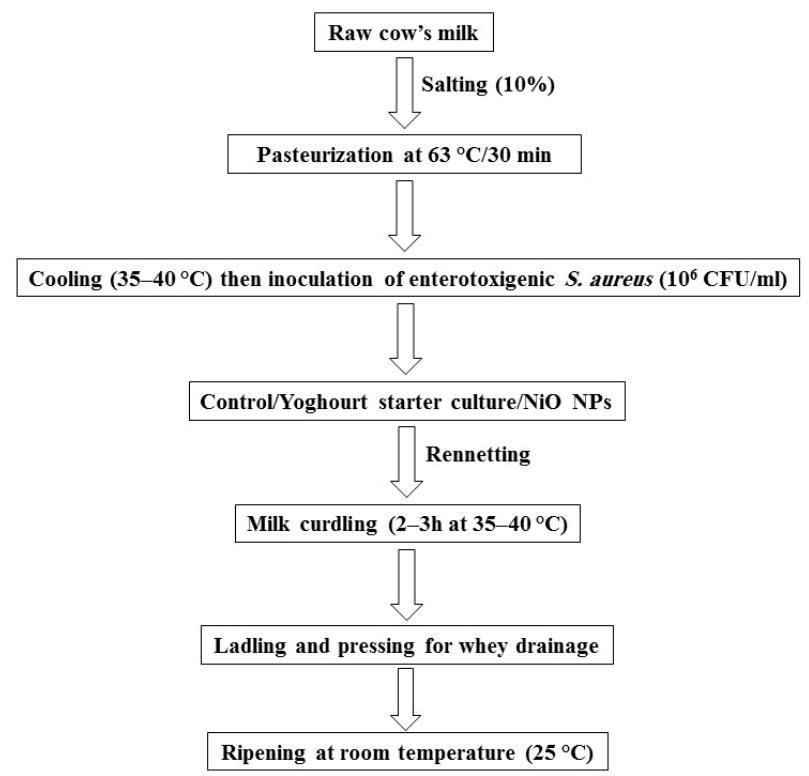
Figure 1. Flow diagram of Domiati cheese making. Control cheese; normal cheese without any treatment. Yoghourt starter culture cheese; cheese processed by addition of yoghourt. NiO NPs cheese; Domiati cheese inoculated with 35 µg/mL of NiO NPs.